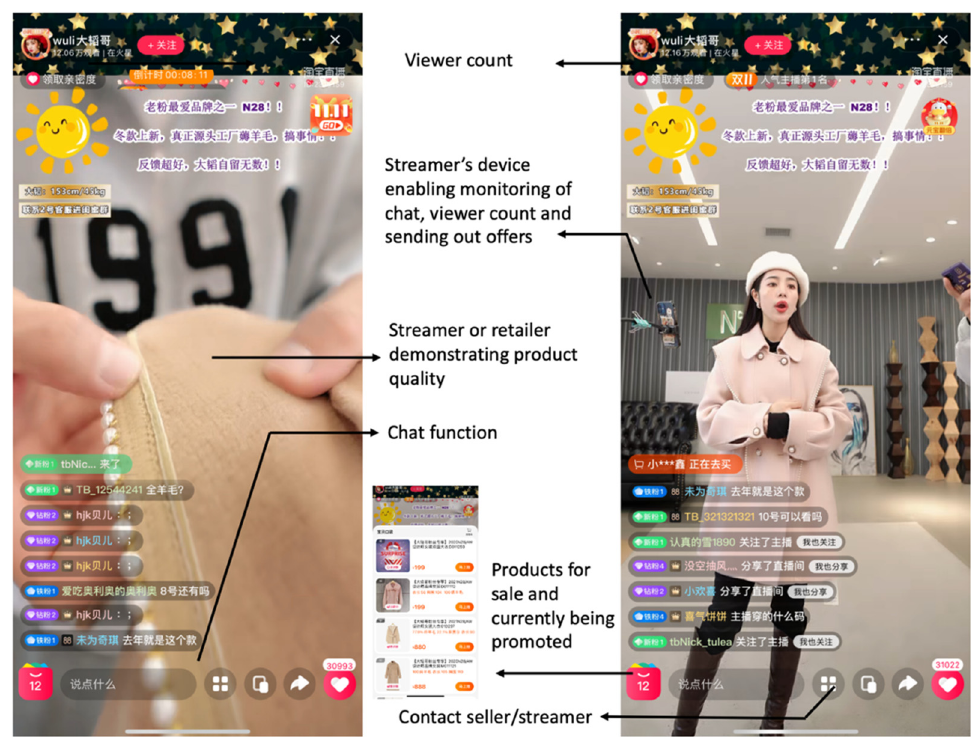
Figure 3. Screenshots taken from a live stream on popular live stream commerce application Taobao, demonstrating the functionality between streamer and consumer.